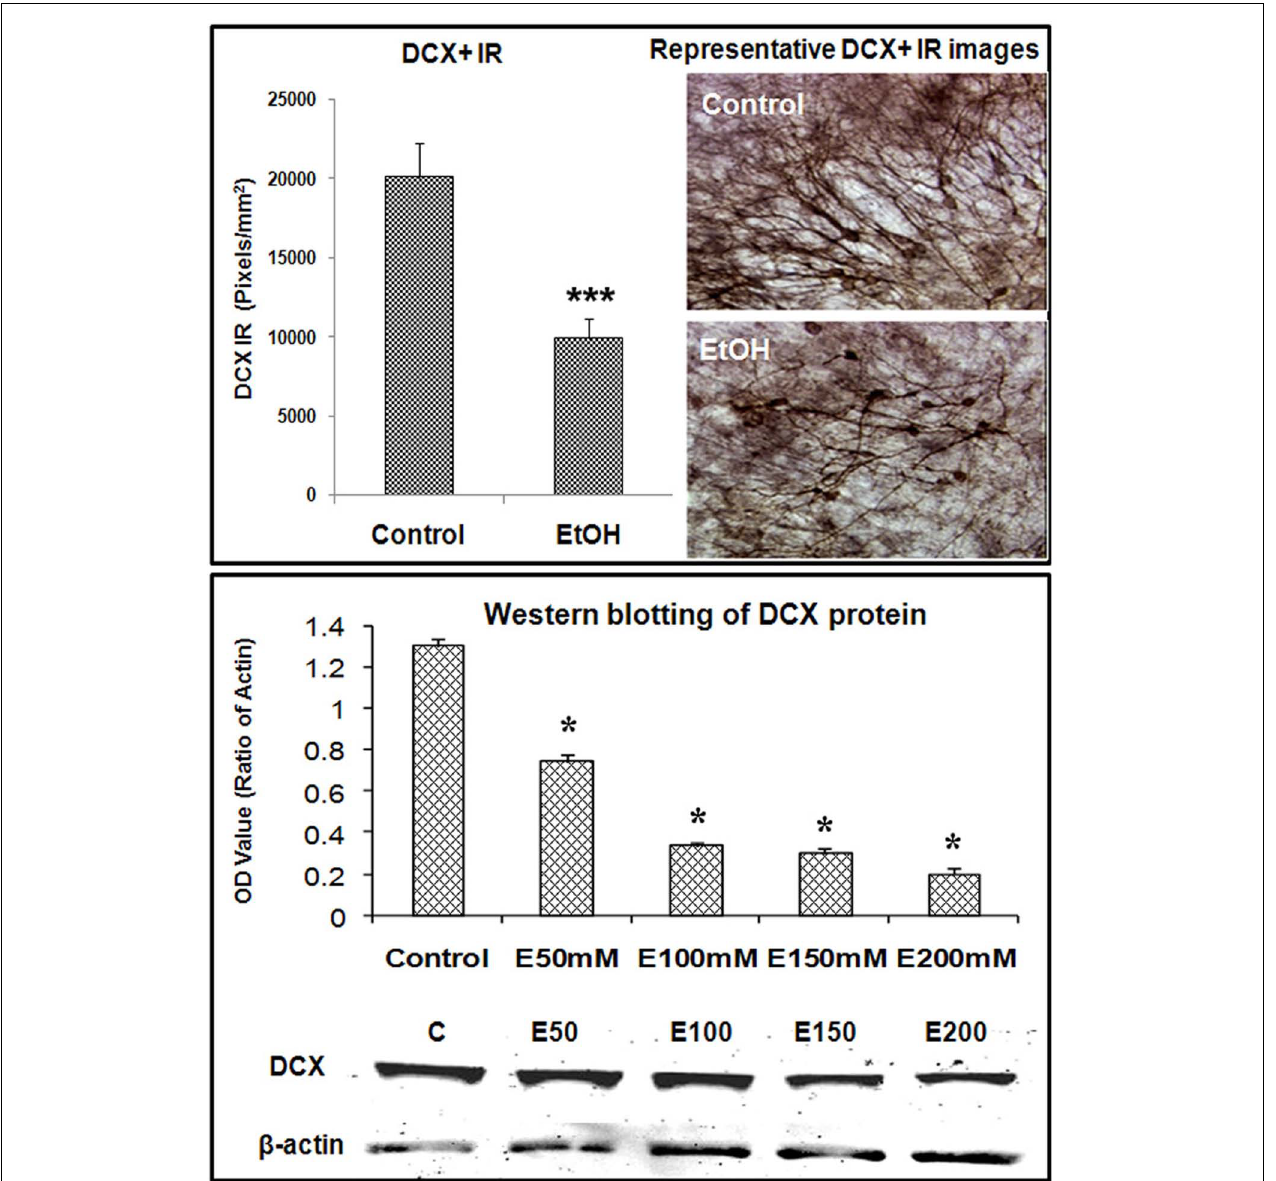
ethanol treated cultures were shown in the right (original magnification 40 × ). Bottom panel: western blotting of DCX from control and ethanol treated slices. Shown in bar graph are mean ± SEM of DCX optical density values. ANOVA following Fisher post hoc : * p < 0.05 compared with control, n = 4 blots.The images of western blot were shown in the bottom.The experiments were repeated at least three times with similar designs and